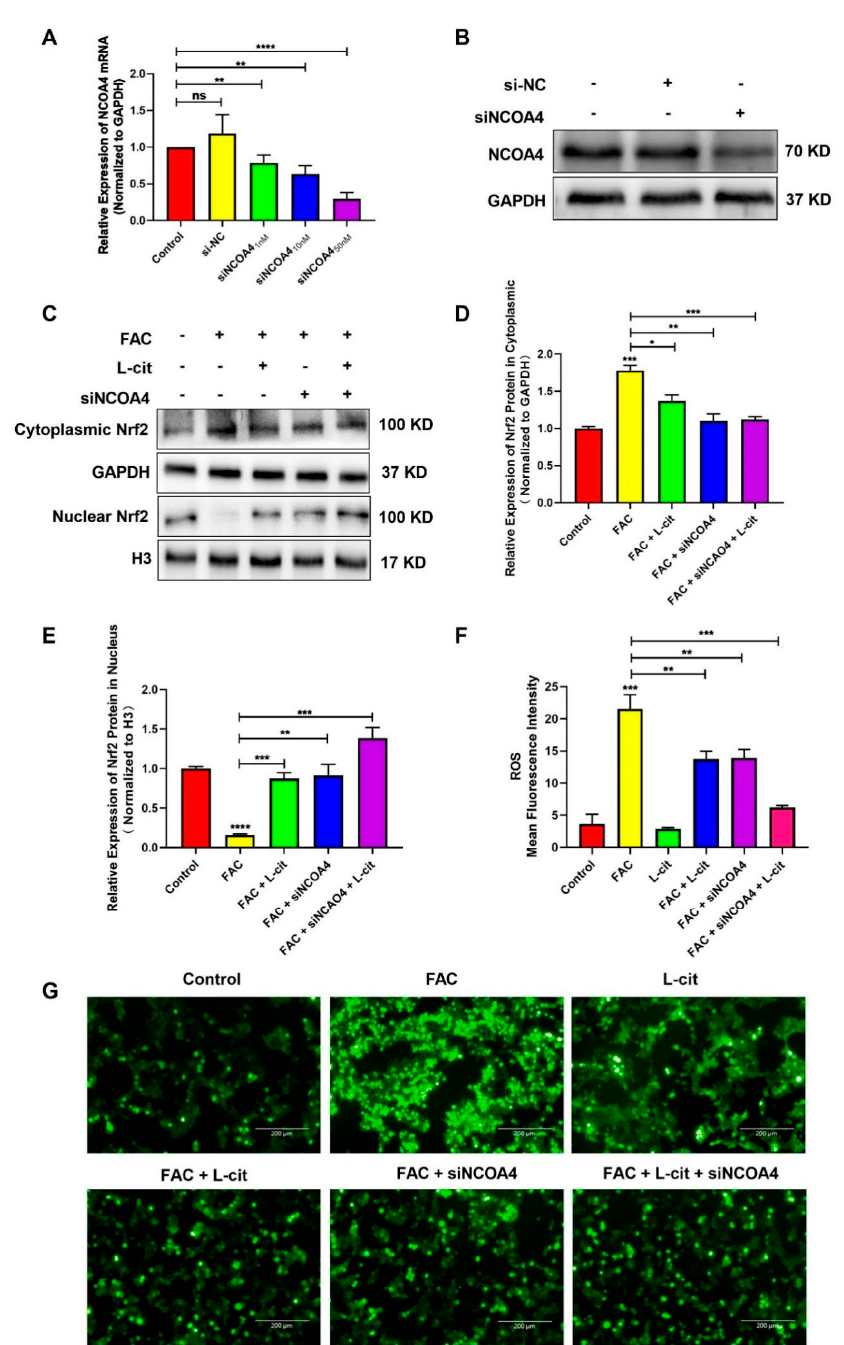
Figure 6. L-cit suppresses ferritinophagy to ameliorate FAC-induced cytoplasmic ROS accumulation in the mTEC1 cells. ( A ) Determination of siNCOA4 concentration. mTEC1 cells were transfected with negative control siRNA or different concentration of siNCOA4 to detect the NCOA4 mRNA level. ( B ) Confirmation of siNCOA4 concentration by qPCR and NCOA4 protein quantitation by western blotting after transfection with 50 nM siNCOA4. The mTEC1 cells were transfected with 50 nM siNCOA4, followed by 2 mM L-cit, and treated with 200 µ M FAC for 24 h. ( C , D ) Immunoblot analyses of Nrf2 in cytoplasm. GAPDH were used as the loading control. ( C , E ) Immunoblot analyses of Nrf2 in nucleus. H3 was used as the loading control. ( F ) ROS mean fluorescence intensity. ( G ) Cytoplasmic ROS level. Values represent mean ± SEM. of three independent experi- ments. Significant differences are represented by * p < 0.05, ** p < 0.01, *** p < 0.001, **** p < 0.0001, ns (not